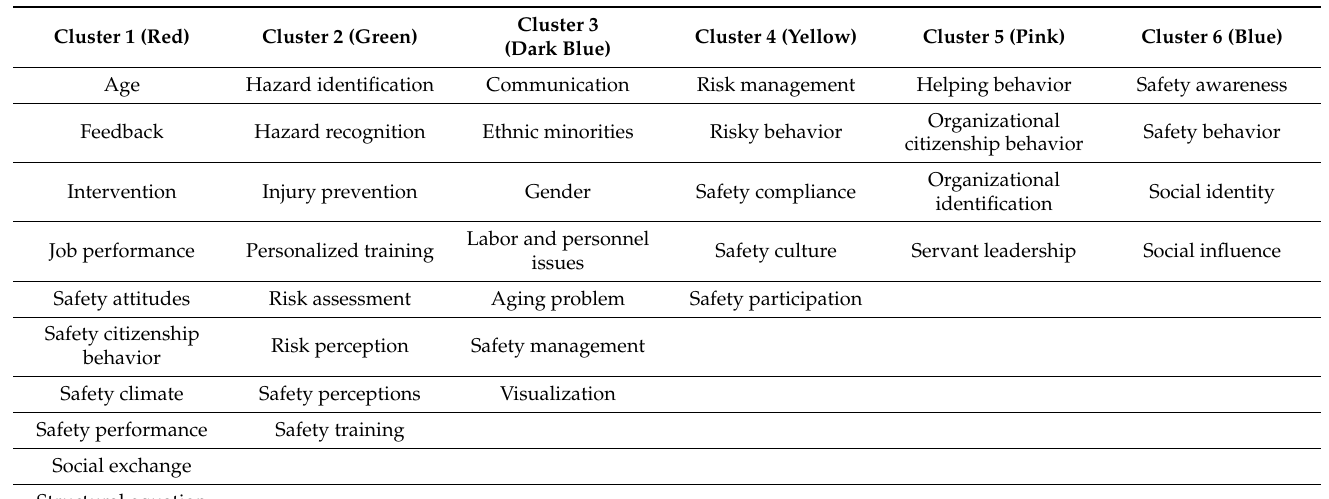
Table 2. Cluster classification of